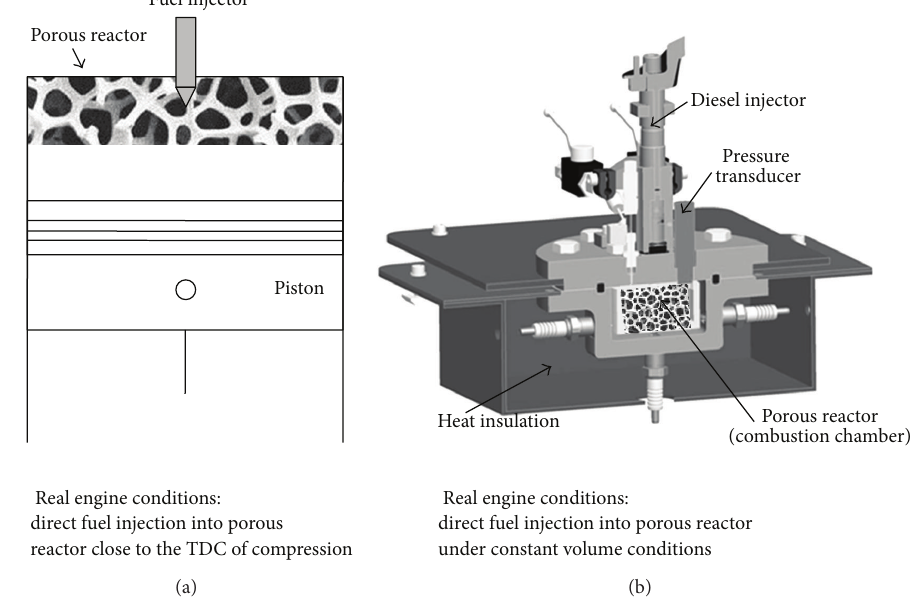
Figure 2: (a) The principle of real engine with combustion in a porous reactor; (b) engine simulator (combustion chamber) simulating engine conditions at TDC of